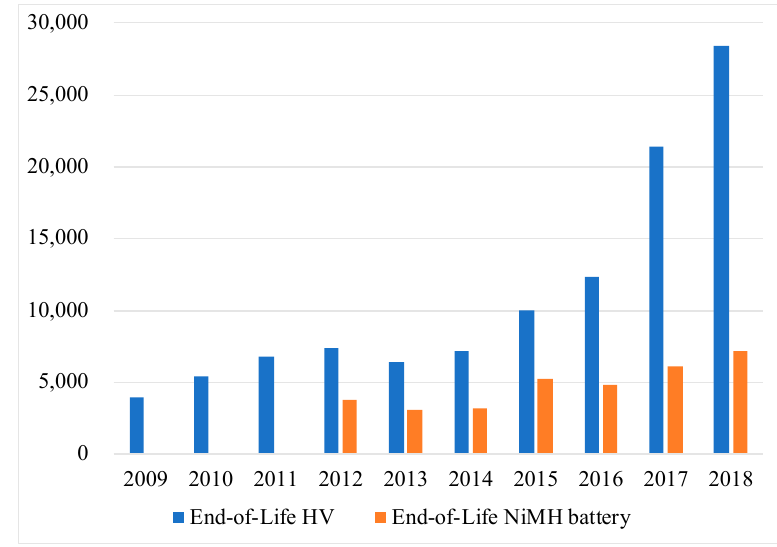
Figure 13. End-of-Life HV and NiMH number in Japan. Source: Figure made by the author based on the data from Japan Automobile Recycling Promotion Center and Japan Automobile Manufacturers Association [19,27].